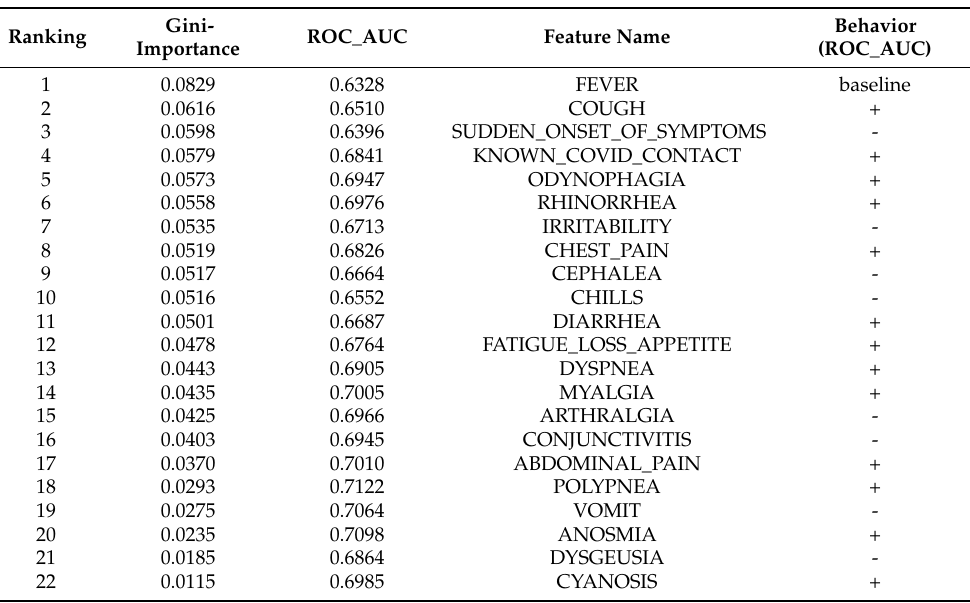
Table 1. Feature importance from the 22 independent variables in the dataset and ROC_AUC scores from fitting the dataset to a baseline random forest classifier by progressively including features according to